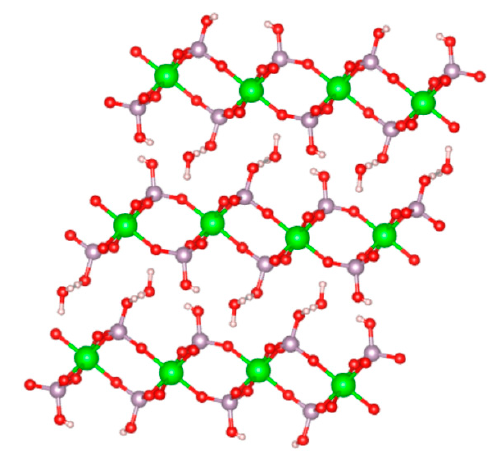
Figure 1. Ball and stick model of the structure of α -ZrP.